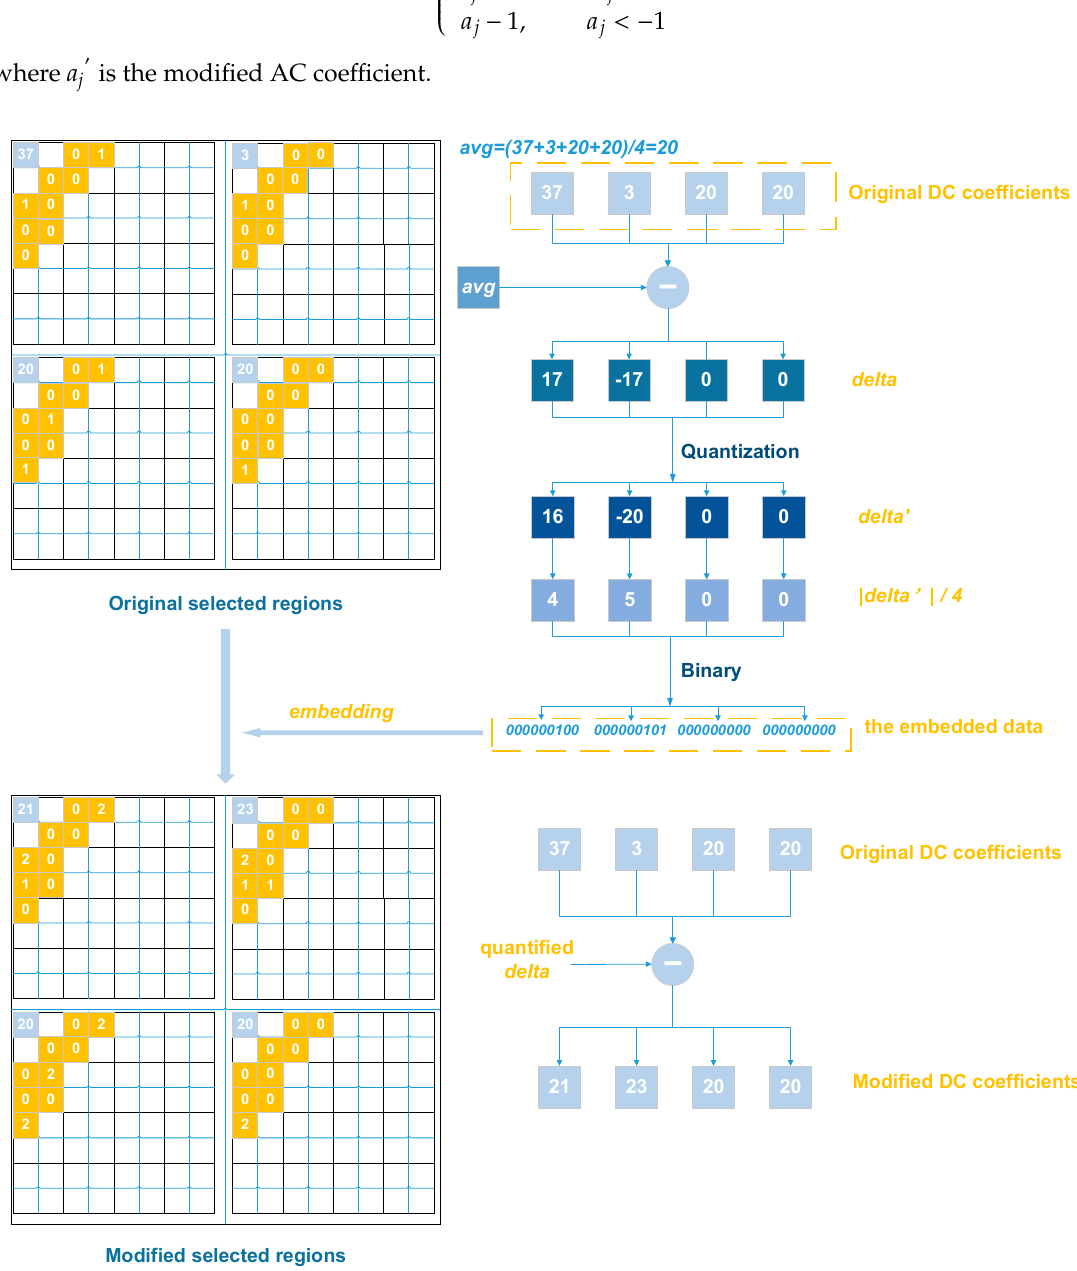
Figure 2. Examples of modifying DC coefficients in selected blocks.